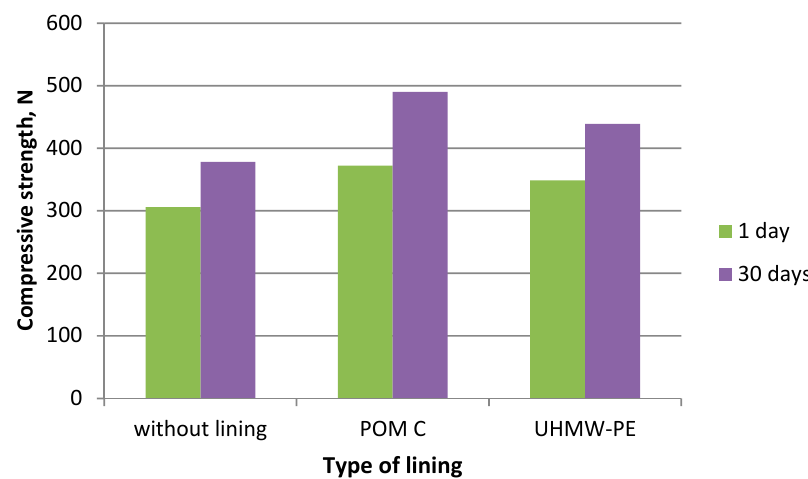
Figure 12. Drop strength of briquettes made of Mixture 6 (EAFD mixture).